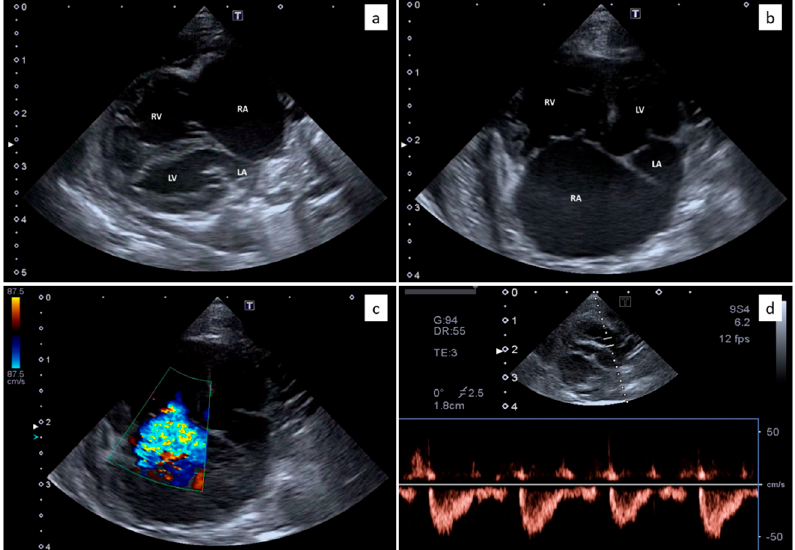
Figure 2. Echocardiography from the domestic kitten showing severe right atrial (RA) and right ventricular (RV) dilation, with reduced dimensions of the left atrium (LA) and the left ventricle (LV) ( a , b ). Moderate to severe tricuspid regurgitation was evident ( c ) with normal morphology of the valvular leaflets. The pulmonary artery systolic flow had a proto-systolic peak ( d